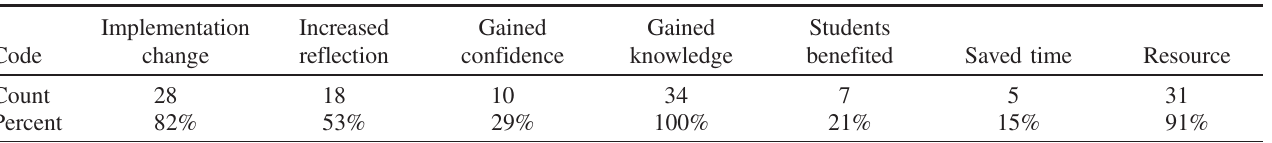
TABLE V. Impacts of participation in the NFW-FOLC. People could fall into more than one category. Count represents the number of participants coded to a category. Percentages are out of 34